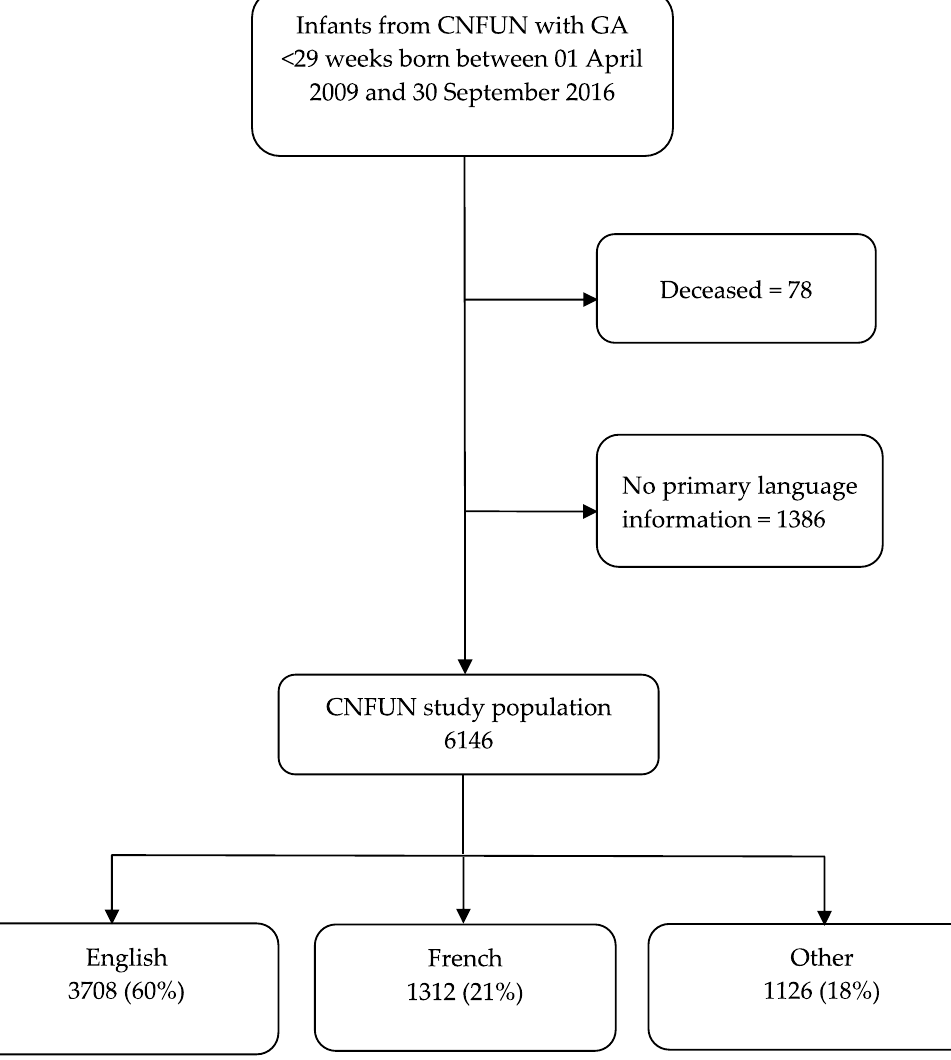
Figure 1. Participant flow diagram divided into groups of primary language at home.